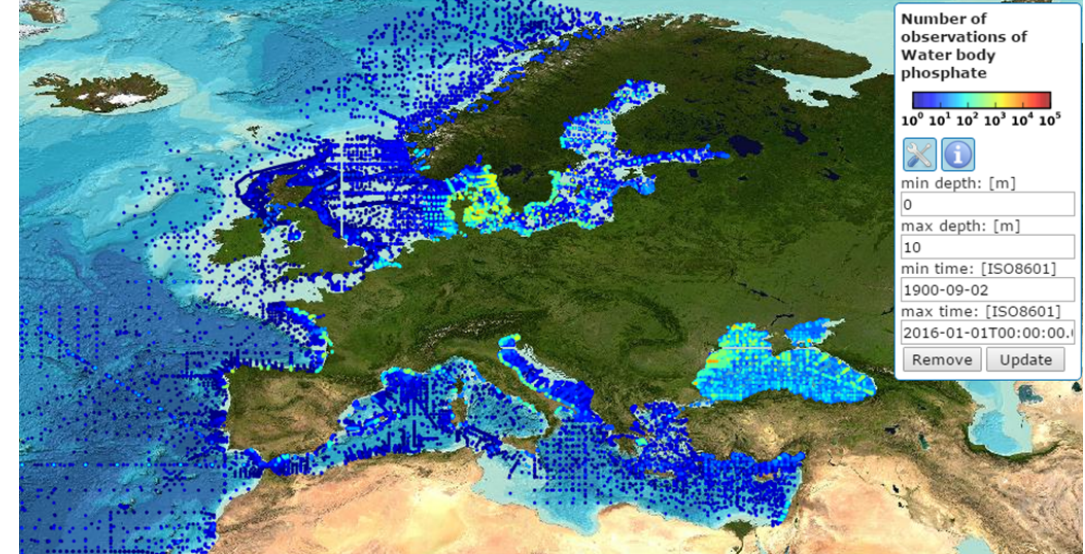
Figure 2. Density and distribution of water body phosphate harvested